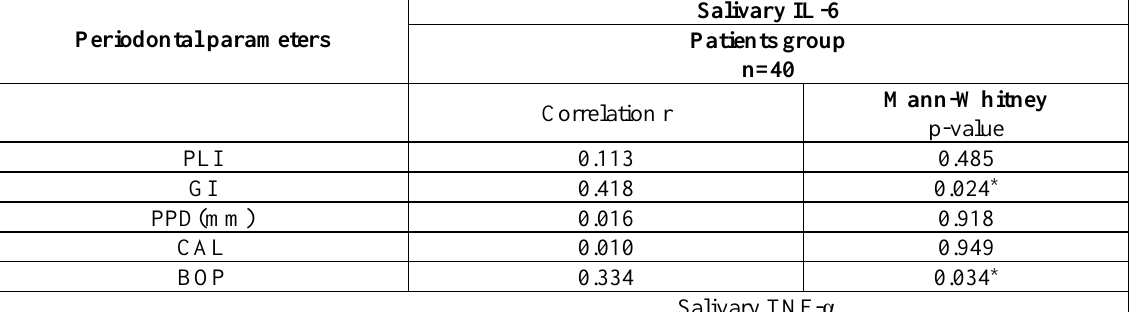
Table 6: Spearman’s Correlation between Salivary IL-6 and TNF-α Levels and Clinical Periodontal Parameters in